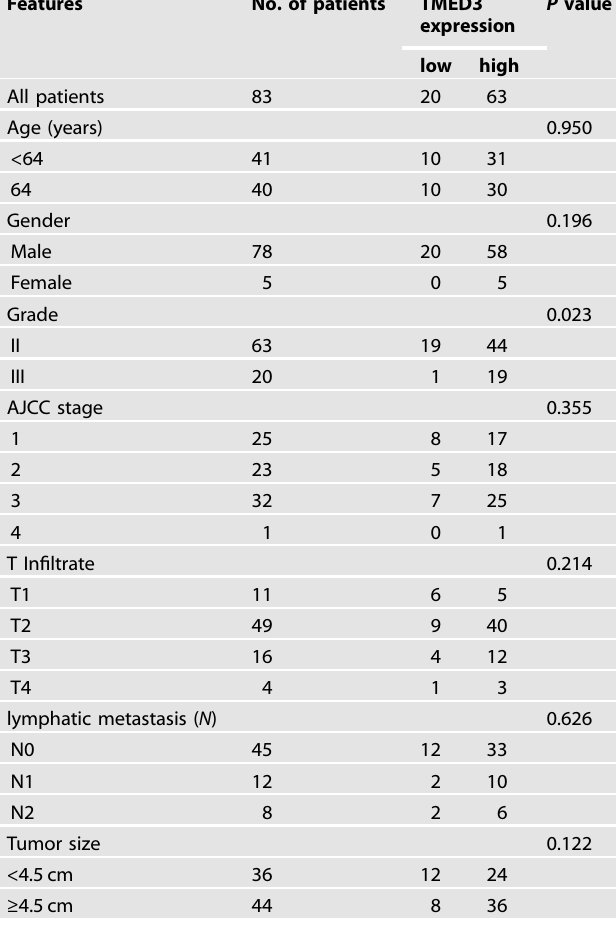
(Fig. S1B) and western blot analysis (Fig., S1C), indicating that depletion of TMED3 in these cell lines exceeded 60%. Subse-